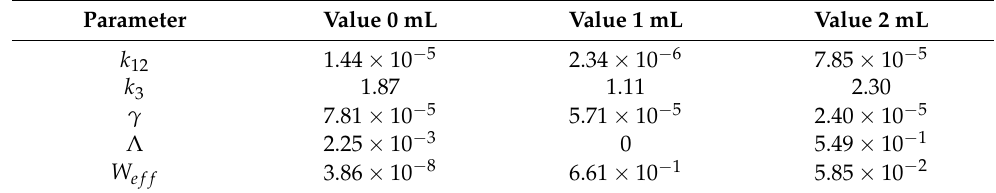
Table 4. Results of the parameter determination for the three different additive classes 0, 1, and 2 mL.